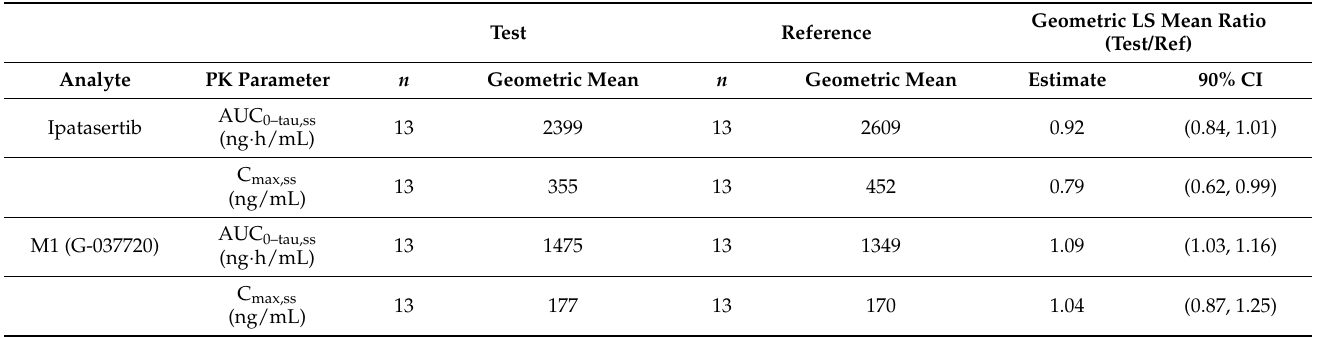
Table 3. Statistical analysis results of ipatasertib and M1 (G-037720) metabolite pharmacokinetic pa- rameters following multiple-dose administration of ipatasertib 400 mg QD alone and in combination with darolutamide 600 mg